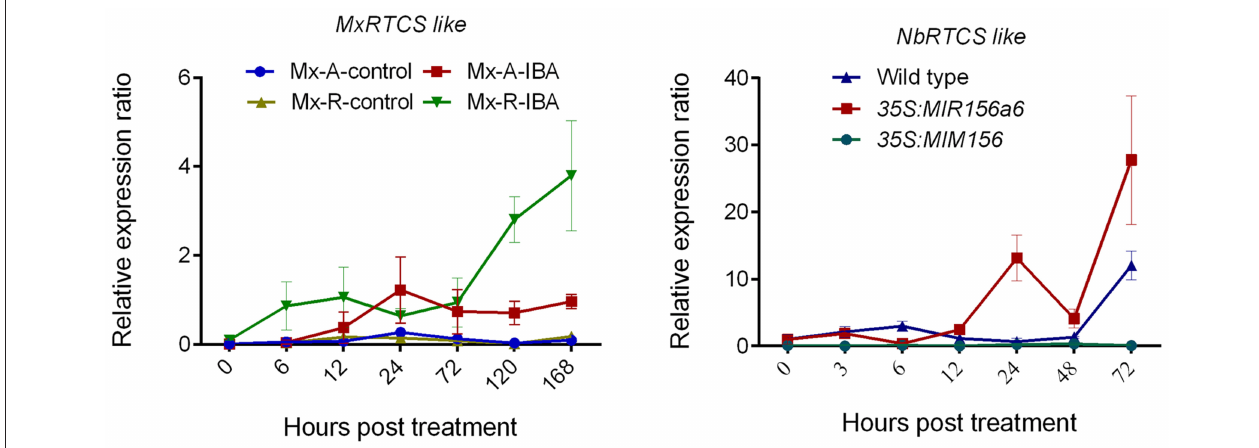
FIGURE 9 | Quantitative RT-PCR analysis the expression profiles of MxRTCS- like and NbRTCS- like genes during adventitious root formation in Malus xiaojinensis and transgenic Nicotiana benthamiana . Bars show SD from three biological replicates.